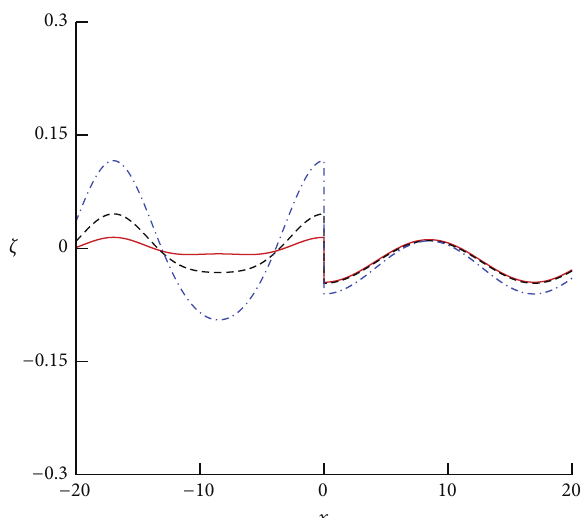
Figure 7: Variation of incident progressive waves and hydroelastic deflection of the plate versus 𝑥 for different plate densities 𝜌 = 0.1 × 10 3 kgm −3 ; dashed line: 𝜌 line: 𝜌 e = 0.9 × 10 3 kgm −3 dotted line: 𝜌 e